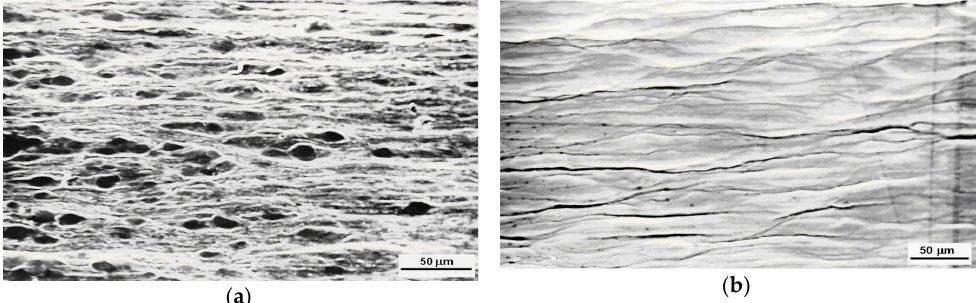
Figure 8. The tube inner surface of the material: ( a ) EW 0.65 mm; ( b ) KT 0.8 mm.